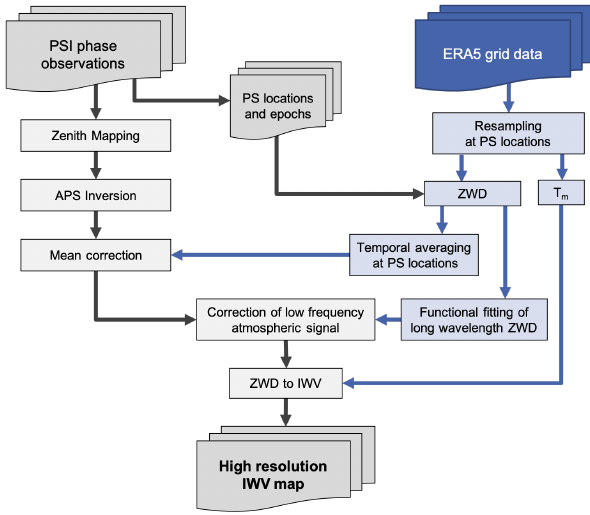
Figure 1. Workflow from PSI phase observations to High resolution IWV